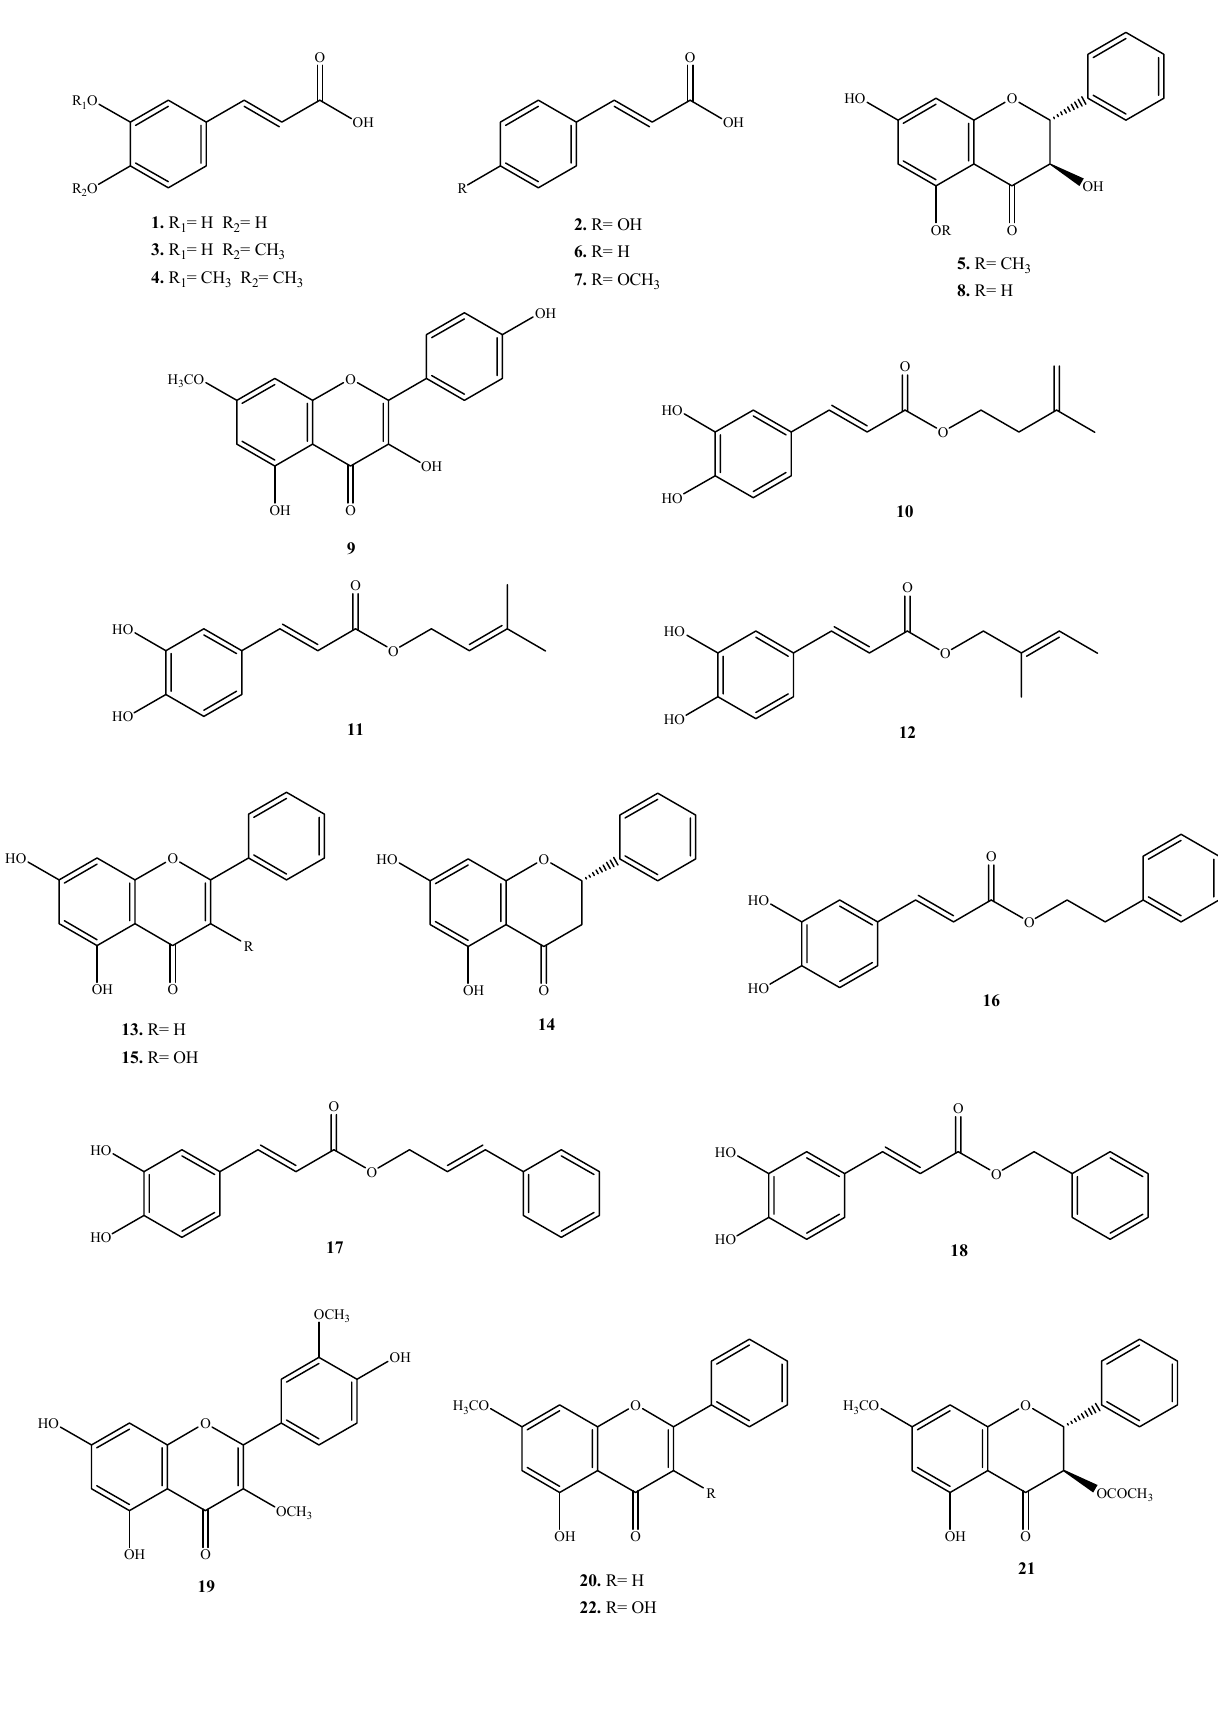
Figure 1. Structures of compounds 1 - 22 from propolis collected in Anhui,